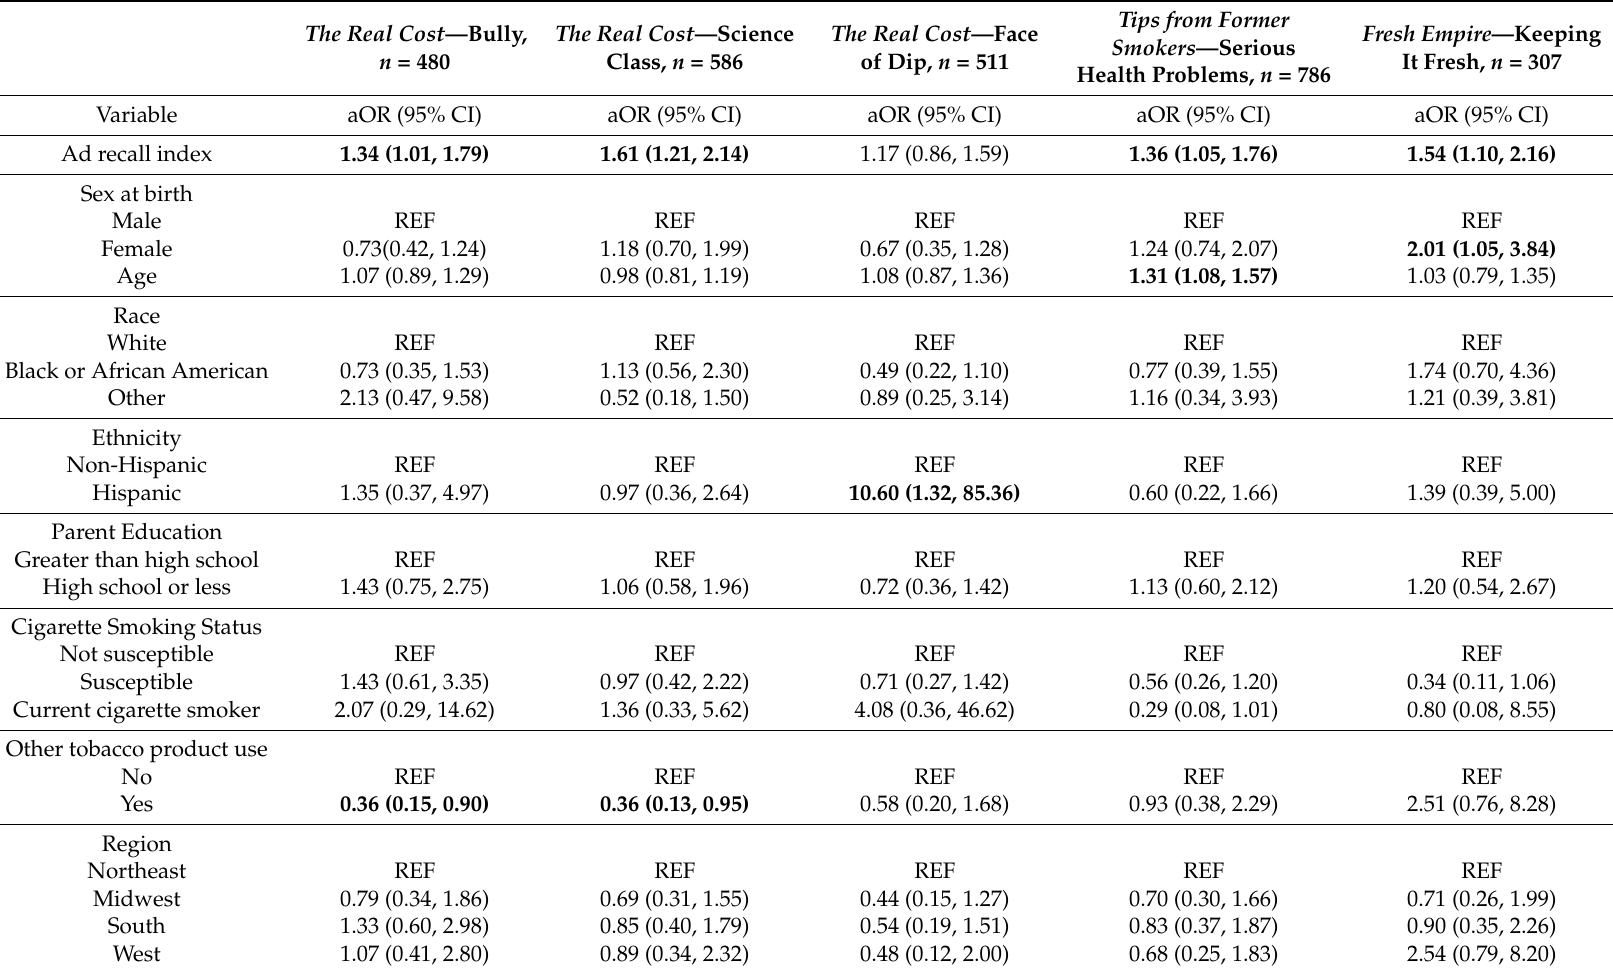
1 Boldface indicates significance p <